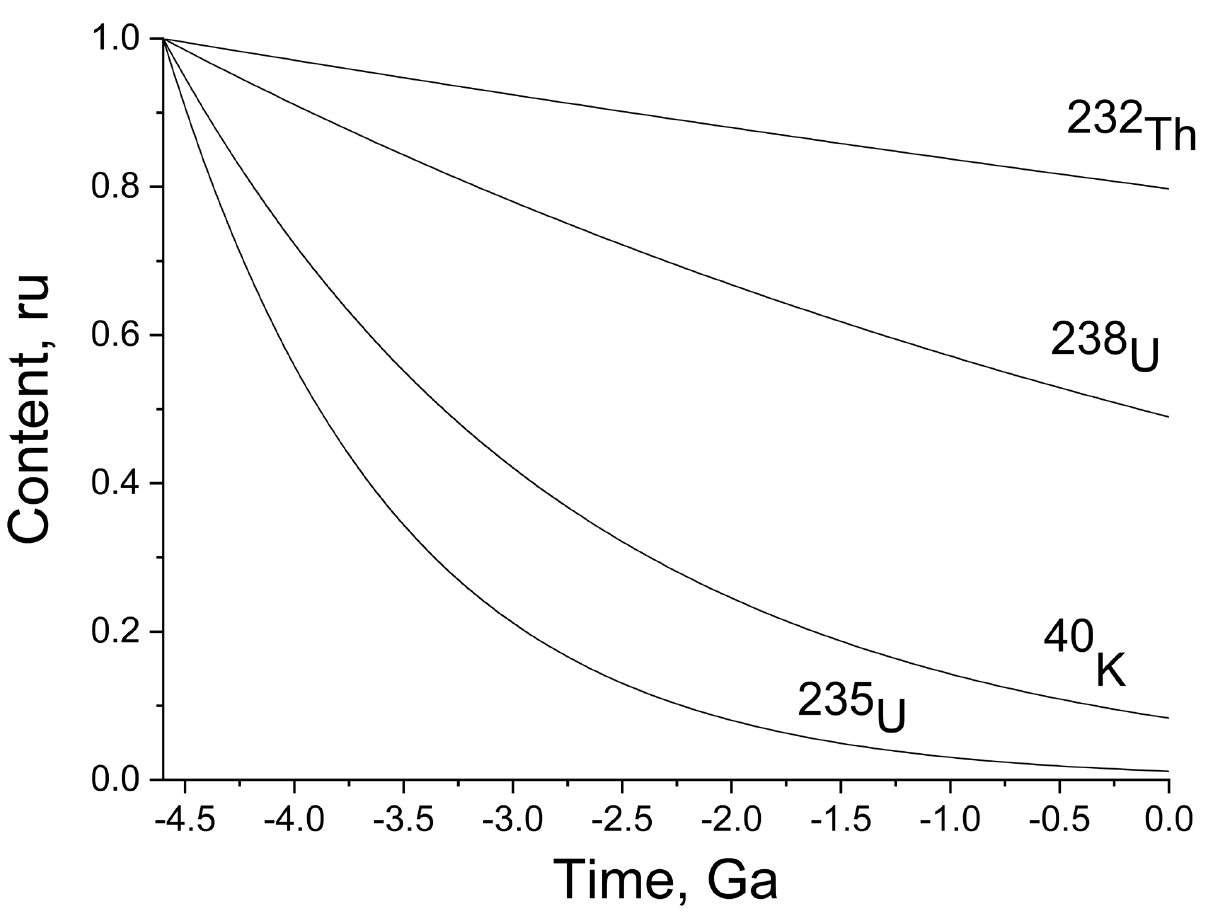
Figure 1. Decay kinetics of the 232 Th, 238 U, 40 K and 235 U isotopes since the origin of Earth. The concentration is presented in relative units corresponding to the fraction of the initial amount. The absolute amount (mass) can be easily calculated by multiplying the fraction (Figure 1) by the isotope mass in grams, given in Table 1. The content of 40 K decreased approximately 10-fold relative to the initial amount. The radioactive isotopes that quantitatively prevail now are those of thorium and uranium (approximately 80% and 50% relative to the initial amounts).